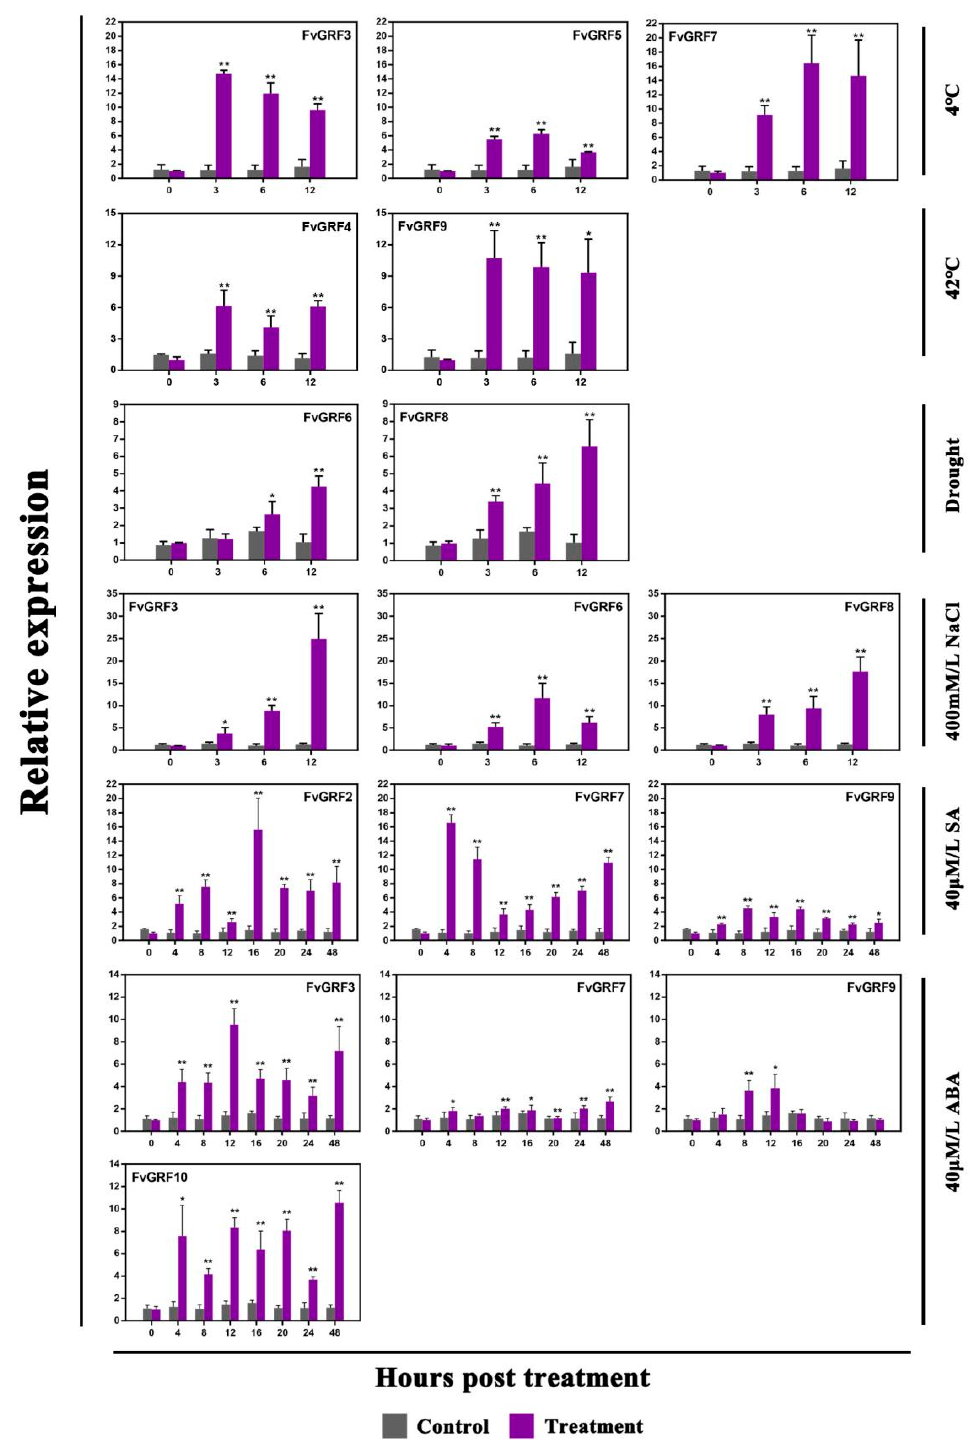
where red indicates an increase and green indicates a decrease, relative to that at 0 h. The experiment was repeated three times and the results were consistent.